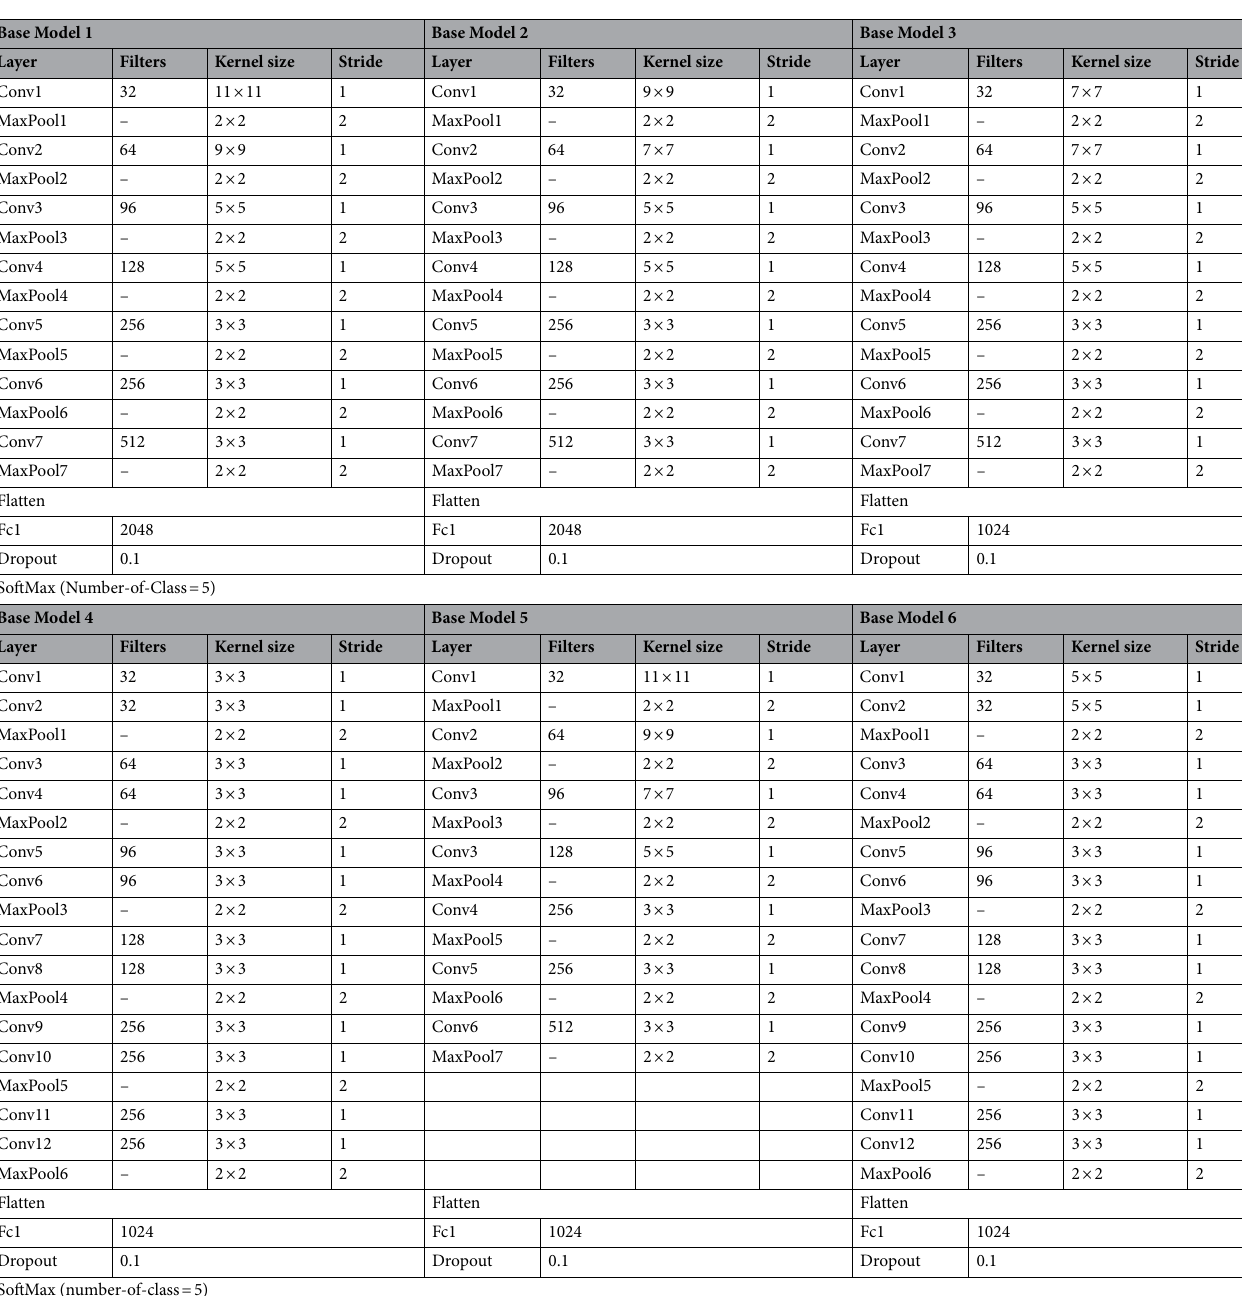
Table 6. Network architecture of the base models in the stacked ensemble